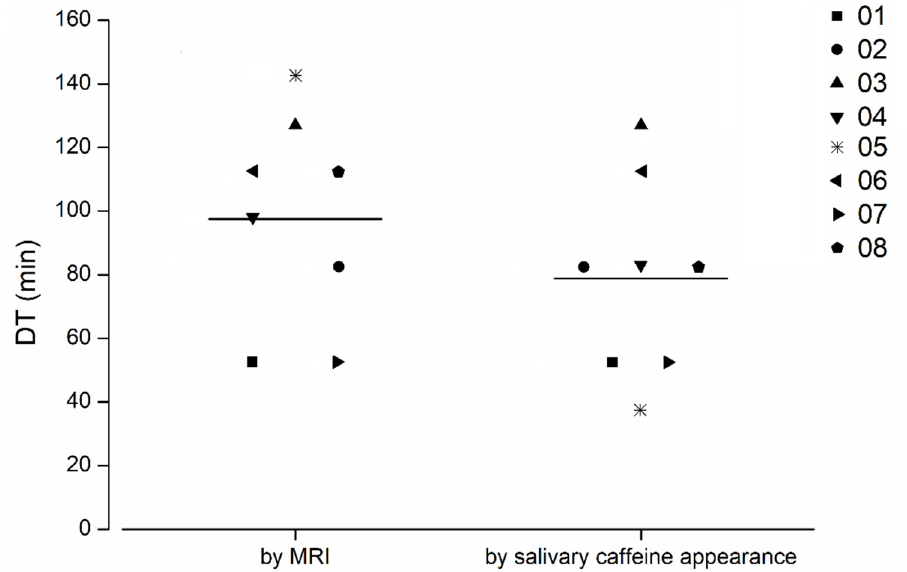
Figure 4. Disintegration time (DT) as determined by MRI and caffeine appearance (n = 8). Capsule disintegration in the colon is highlighted as a star (volunteer 05); the mean disintegration time is marked by a horizontal bar.